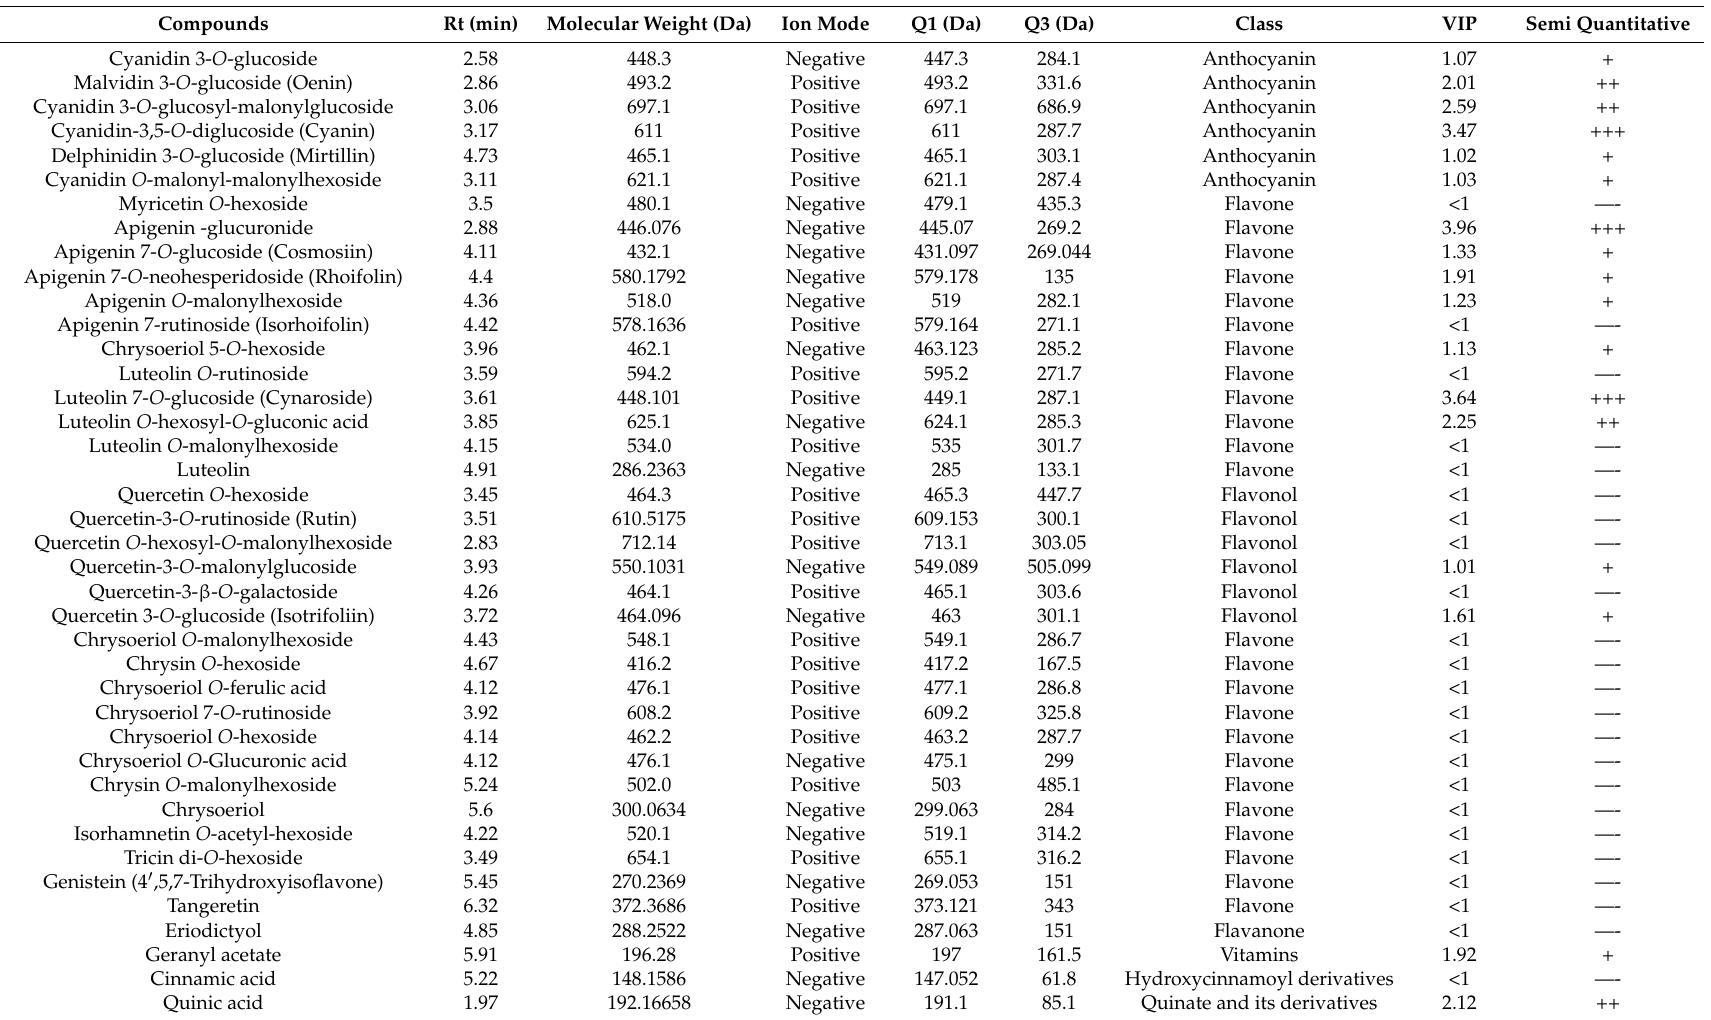
Table 1. Main phytochemical composition identified via Quadrupole–Orbitrap MS/MS in six red-lettuce